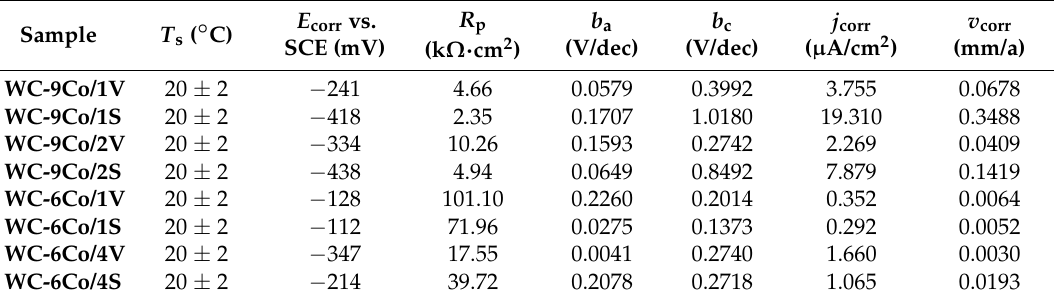
Table 3. The results of electrochemical DC techniques [15].